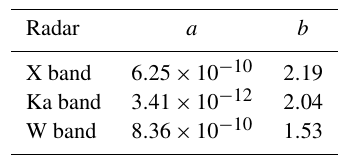
Table 7. Coefficients a and b for the sensitivity fit (Eq. 2) obtained for the X, Ka, and W band. The coefficients were calculated using the Level 2 dataset with filtering according to the error flags applied (see Table